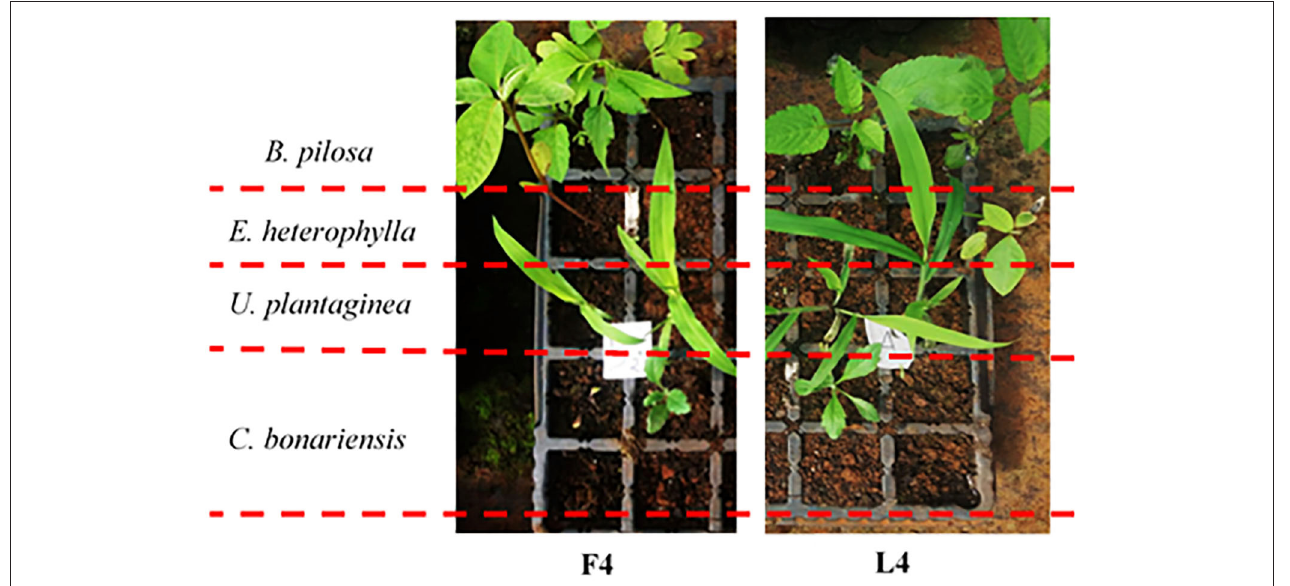
FIGURE 1 | Illustration after the 15th day of treatment with the biocompound produced.